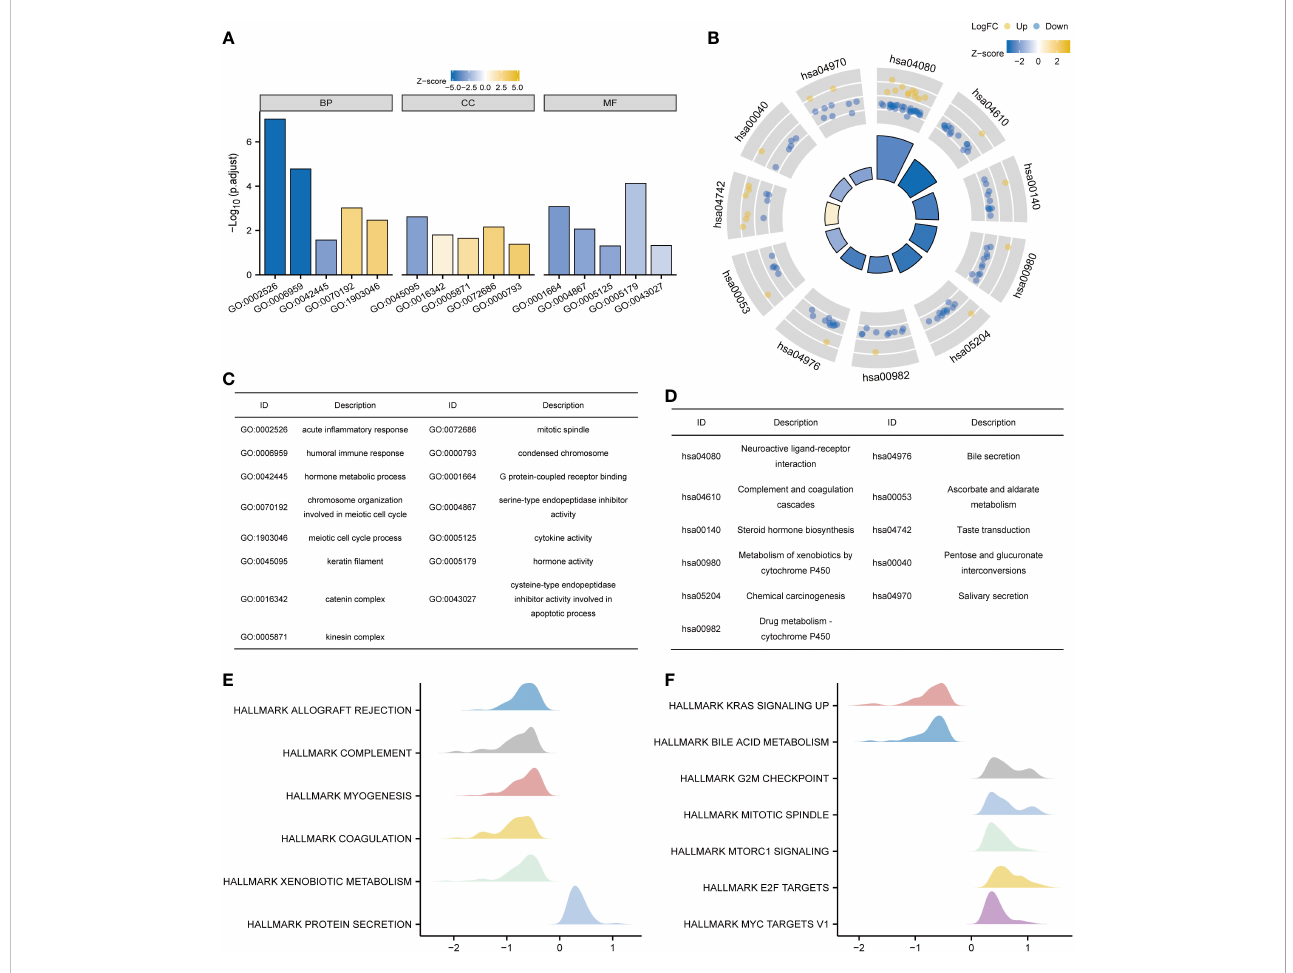
FIGURE 4 Functional enrichment analysis of KNL1 and related differentially expressed genes in UCEC. (A) Results of GO analysis. (B) Results of KEGG analysis. (C, D) GO and KEGG analysis category names corresponding to the GO and KEGG Identi fi er. (E, F) Results of KEGG analysis. When the abscissa was positive, KNL1 expression was positively correlated with this pathway, and when the abscissa was negative, the opposite was